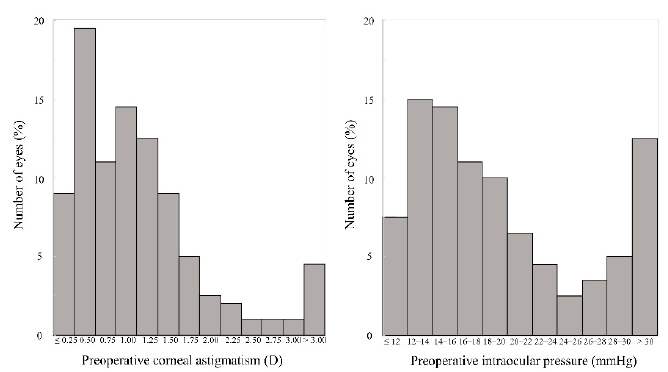
Figure 1. Graph showing the distributions of the preoperative corneal astigmatism and the intraocular pressure. Table 1. Preoperative and postoperative demographics of the study group undergoing trabeculectomy and demographics of the control